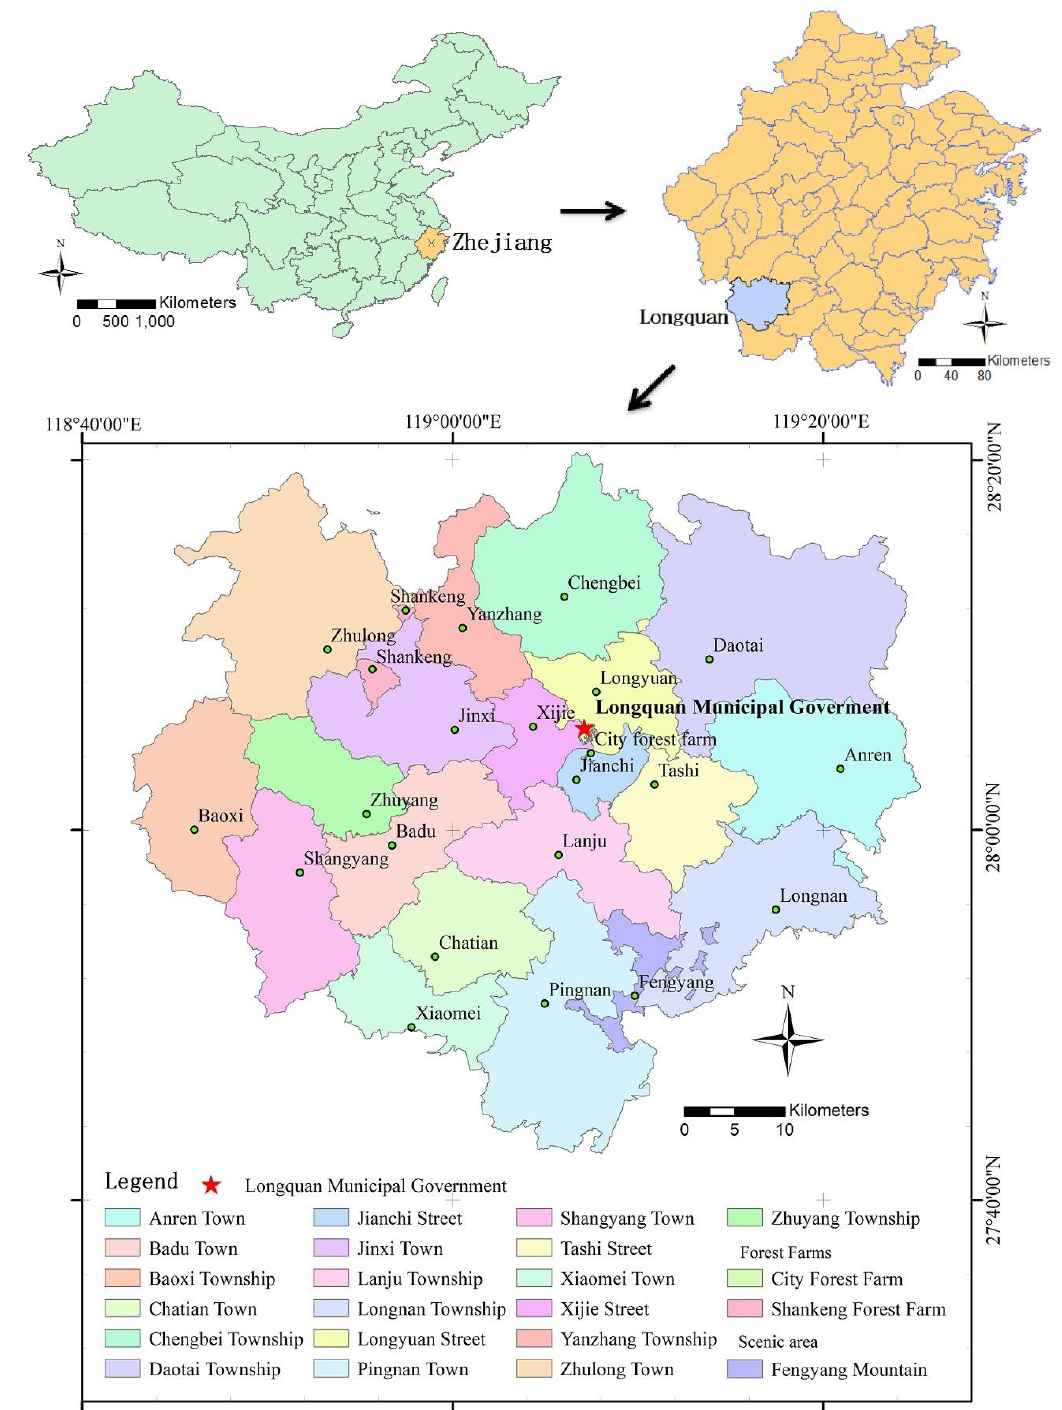
Figure 1. Administrative map of the study area. 89